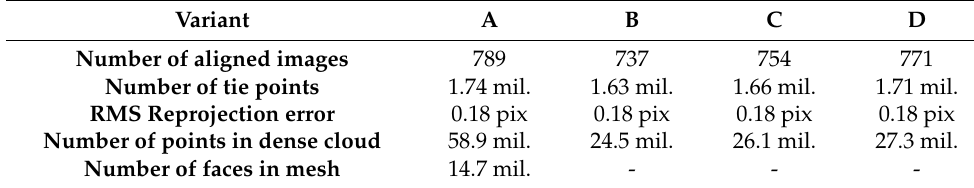
Table 4. Results of photogrammetric